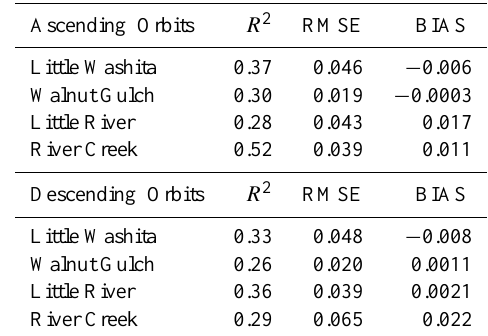
Table 2. Statistical parameters of the relationships between mea- sured and estimated averaged values of SMC (in m 3 m − 3 ) for each ARS test area and for both ascending (top) and descending (bottom)